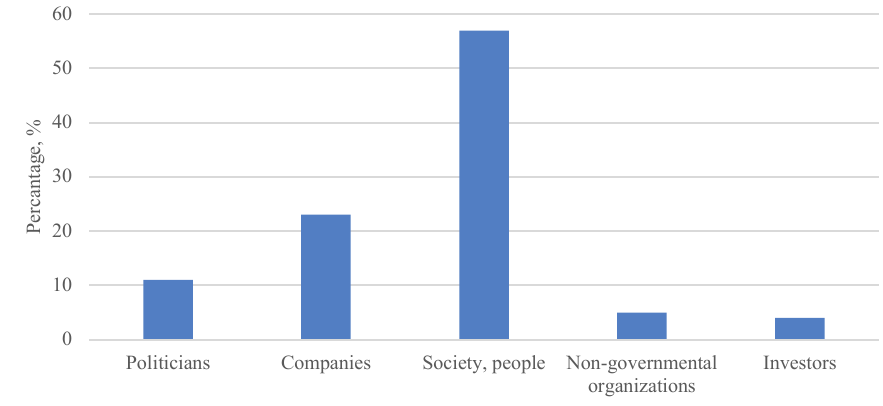
Fig. 6. To whom the reduction of emissions is more critical in Latvia on respondent’s opinion.